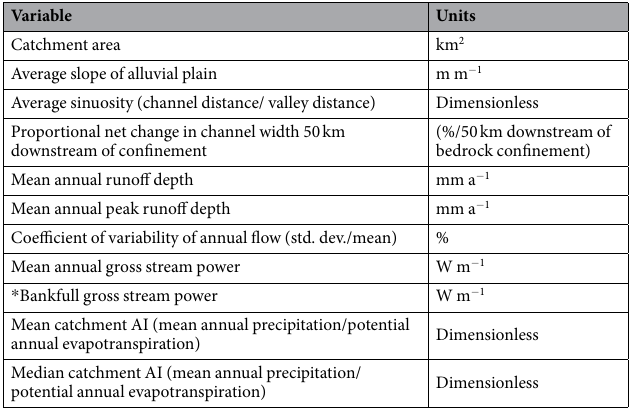
Table 2. Variables used in ANOSIM and their units. Geomorphological measures were calculated using Google Earth satellite imagery and a 30 m SRTM DEM. (Note: * not used in statistical